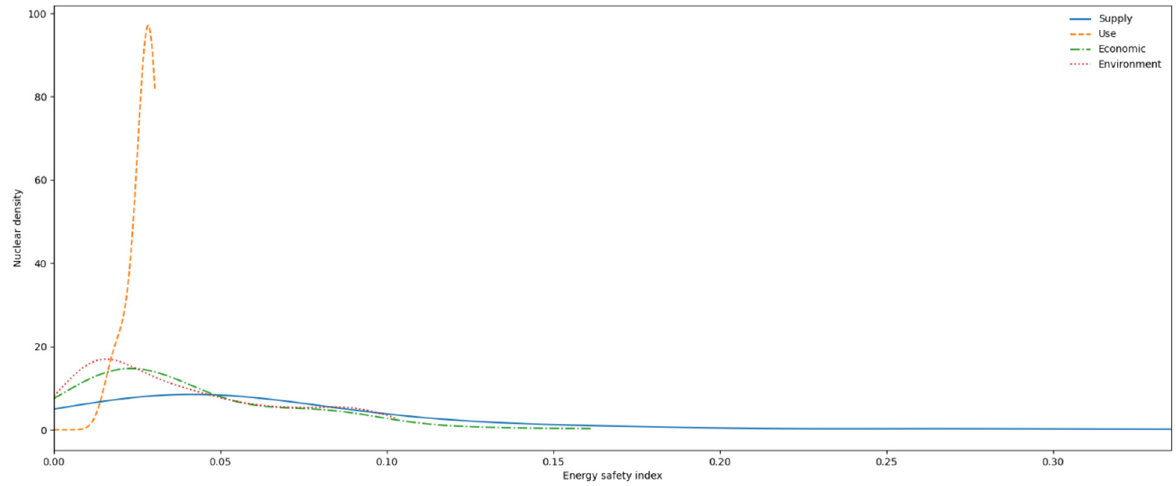
Figure 14. Kernel density distribution in different dimensions of global energy security.